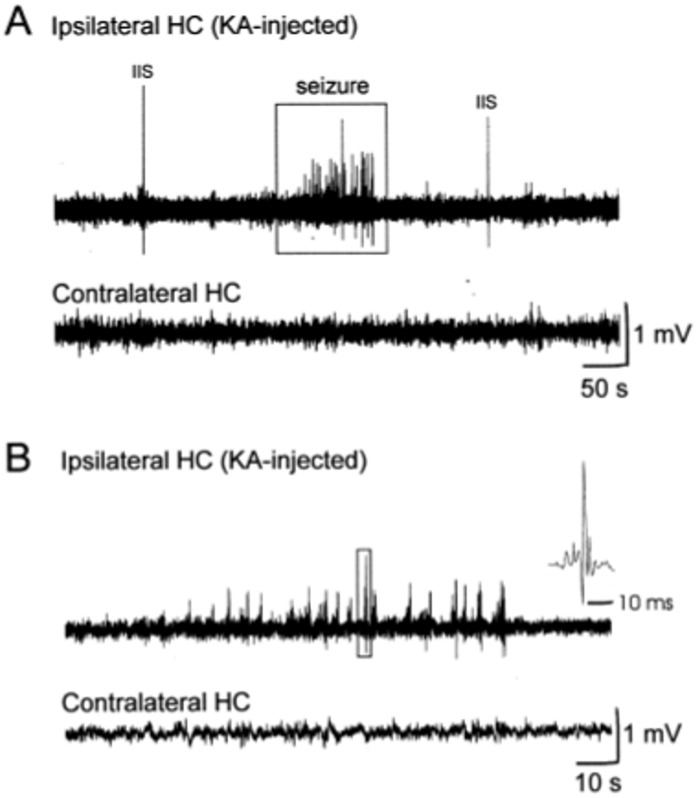
EEG recording of a chronic-phase seizure in a freely behaving KA rat.(A)Top: The kainate-injected ipsilateral hippocampus shows a quiescent period with a single inter-ictal spike (IIS) followed by a seizure (enclosed in box). Bottom: The contralateral hippocampus was seizure-free. (B)
Top: Expanded plot of the seizure with a time-scale of 10 s. The inset shows an expanded plot of the peak in the box with a time scale of 10 ms; the wave pattern is characteristic of a hypersynchronous population burst from glutamatergic neurons. Bottom: Corresponding recording from the seizure-free contralateral hippocampus.